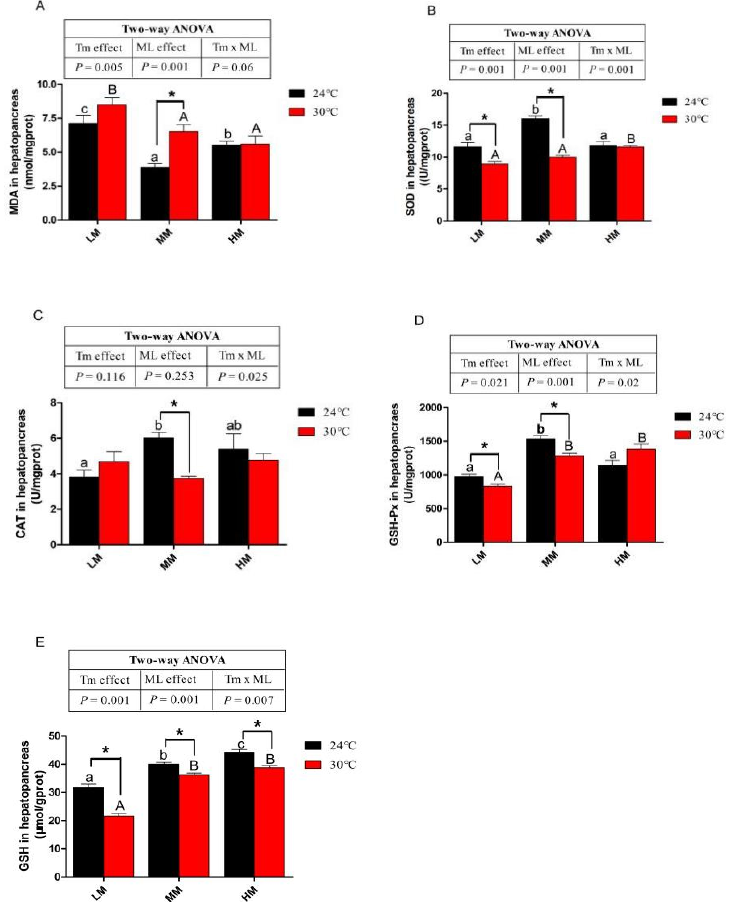
Figure 4. The antioxidative capacity of juvenile E. sinensis fed the experimental diets at normal (24 °C)/high water temperature (30 °C). ( A ) MDA: malondialdehyde; ( B ) SOD: superoxide dismutase; ( C ) CAT: catalase; ( D ) GSH-Px: glutathione peroxidase; ( E ) GSH content. * means that there is a significant difference between different temperatures at the same dietary methionine level ( p <